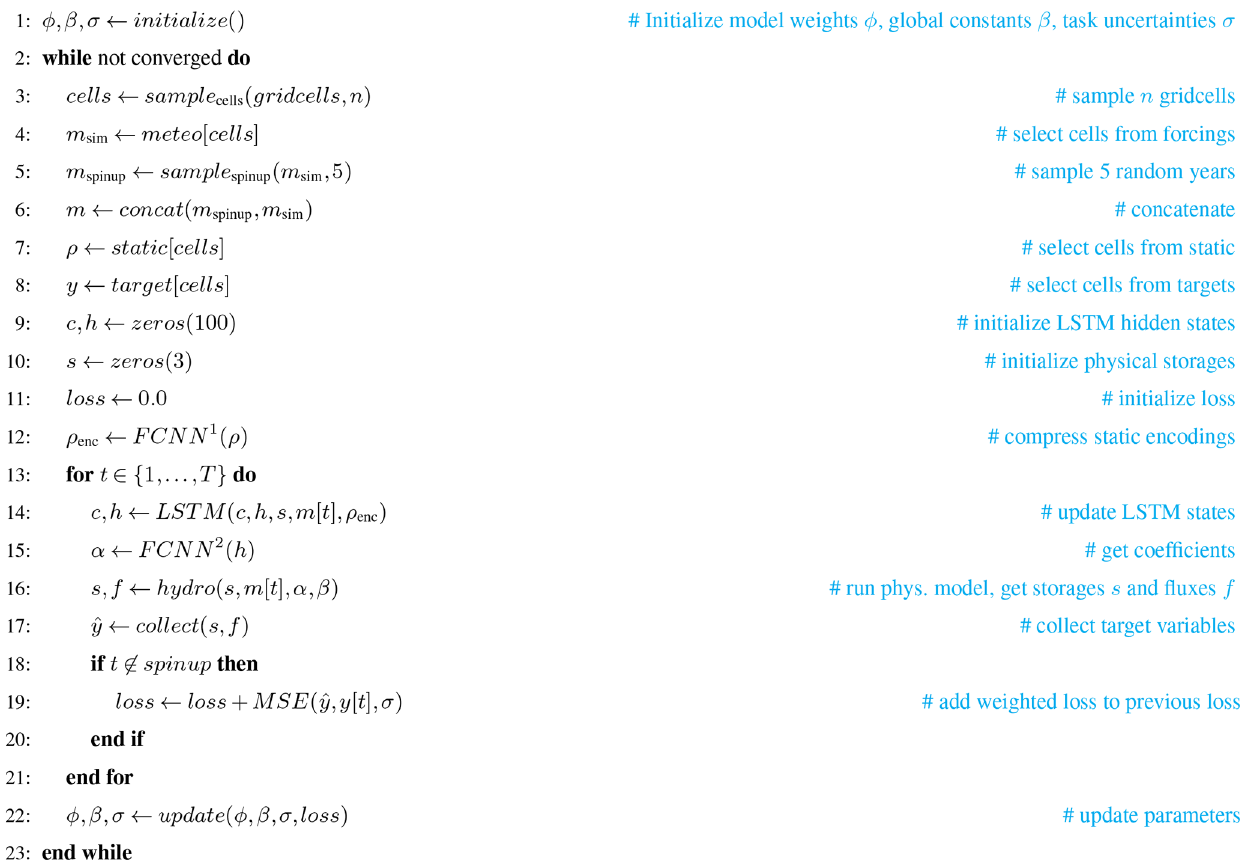
Figure E1. The training loop of the hybrid hydrological model.